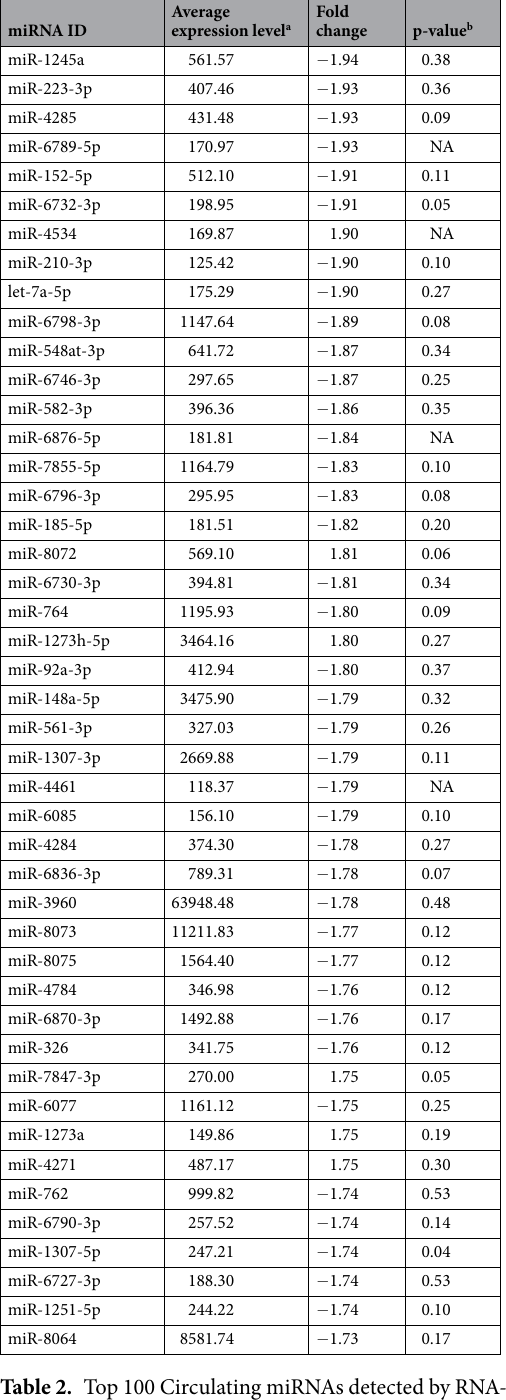
Table 2. Top 100 Circulating miRNAs detected by RNA-seq based screening. a Average value of normalized miRNA read counts. b p -values were calculated by unpaired two tailed t-test. NA: not